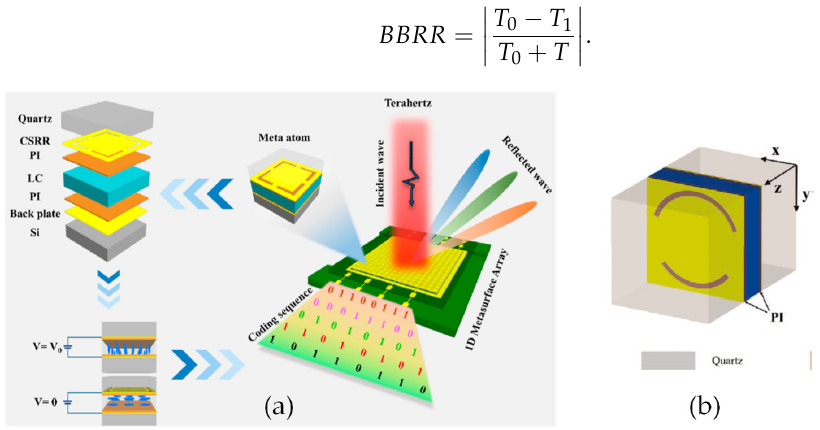
Figure 19. The elements of the array-grating: ( a ) square SRR [86] and ( b ) arc SRR [89]. Reprinted with permission from Ref. [86,89]. 2022 American Chemical Society and 2021 John Wiley and Sons.